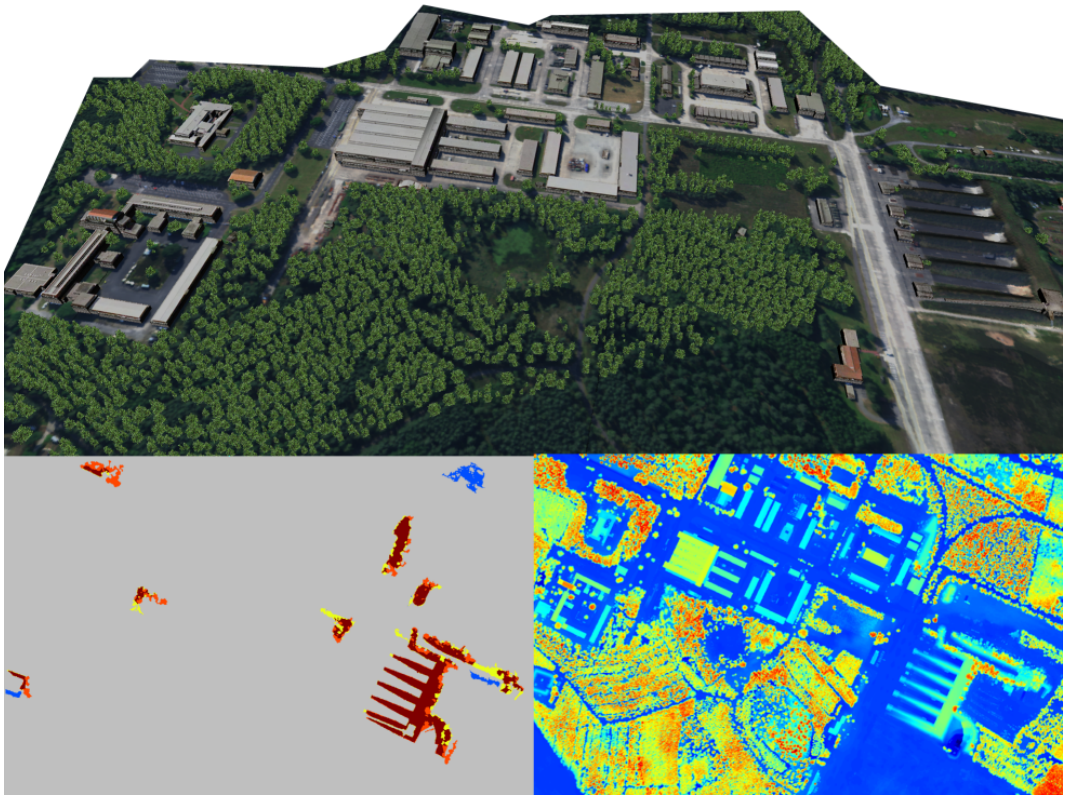
Figure 4: View of a urban terrain reconstruction result for the complete dataset. In the bottom part, on the left: A larger fragment with results for hills detection (see text for details); on the right: The corresponding fragment of the DSM. isolated pixels misclassified as hills are removed. The overlap of the ground truth and our result is depicted in Fig.4, bottom left. The blue color indicates the false negatives: hills in the ground truth but not detected by our procedure. There are three false negatives: One because of its area and two because of the pla- narity measure (see Sec.5). Also, there were no false